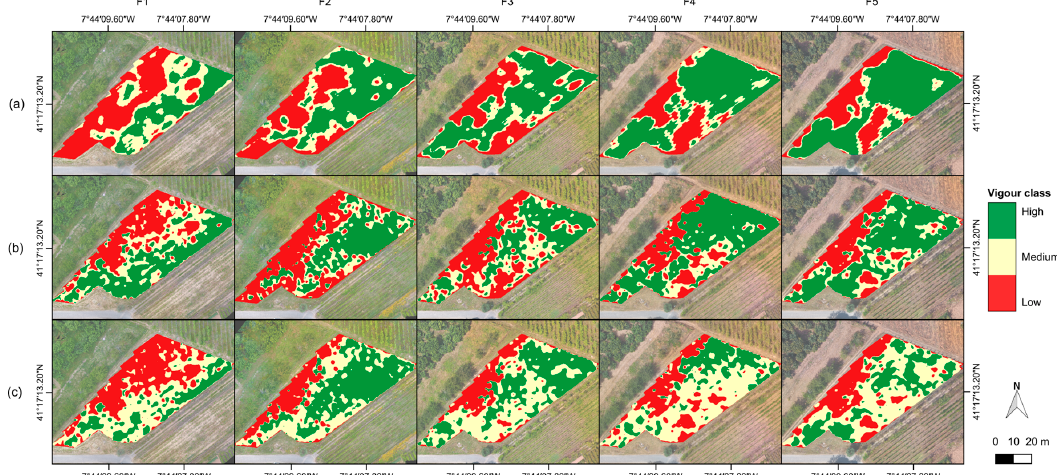
Figure 7. Generated vigour maps, based on the normalized difference vegetation index (NDVI), with three vigour classes (high, medium, and low) for each flight campaign, with the three evaluated approaches: ( a ) considering all vegetation present, ( b ) regarding only the grapevines’ vegetation, and ( c ) considering only normalized grapevines’ vegetation.